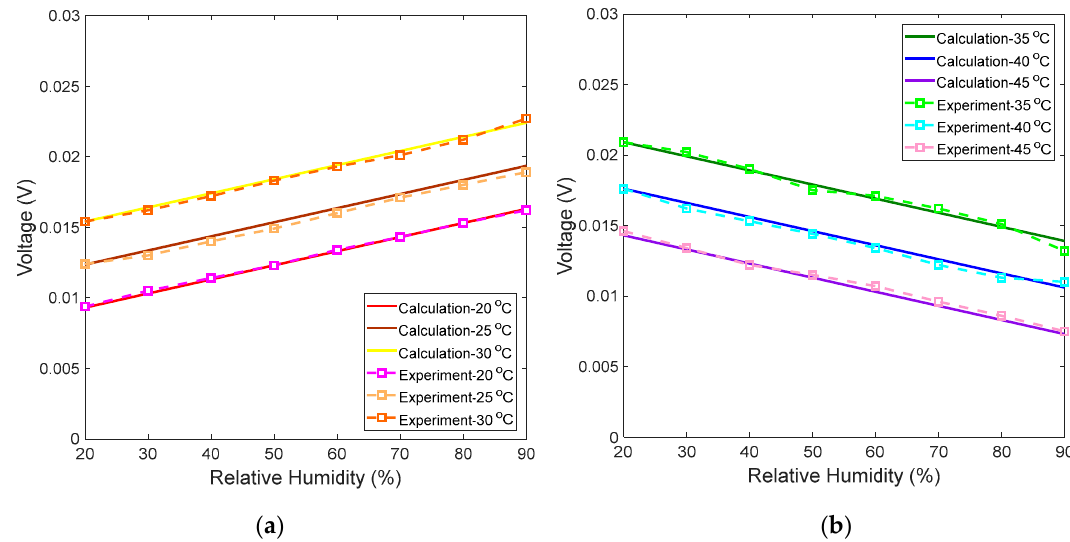
Figure 10. Comparison of calculated and experiment results of voltages vs. RHs at ( a ) 20 °C, 25 °C, and 30 °C, with λ B ; ( b ) voltages vs. RHs at 35 °C, 40 °C, and 45 °C, with λ A .